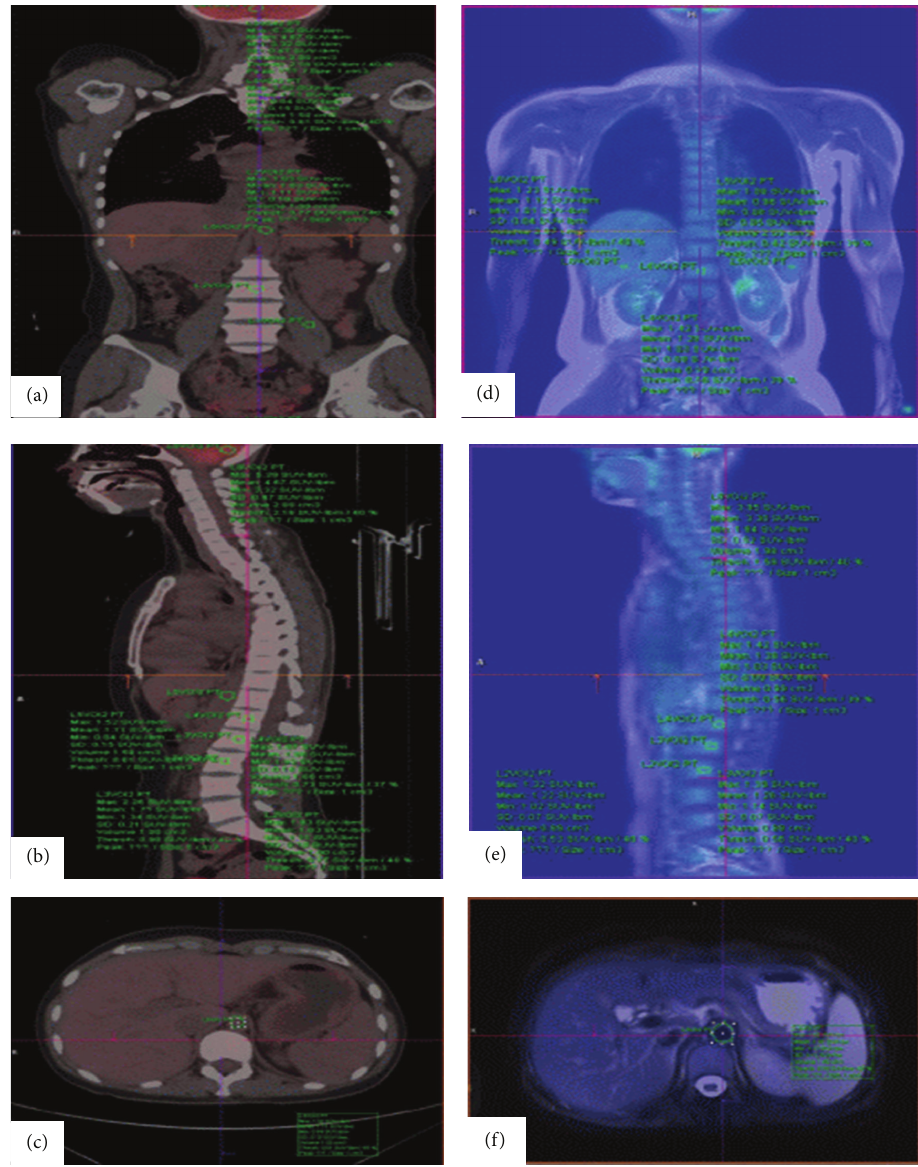
Figure 1: (a) ∼ (c) SUVs measurements confirm anatomical location in the PET/CT coronal, sagittal, and transverse images; (d) ∼ (f) SUVs measurements confirm anatomical location in the PET/MRI coronal, sagittal, and transverse